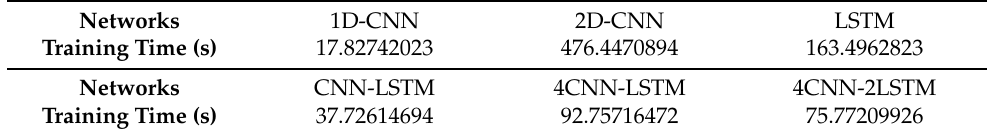
Table 4. The networks training time at 50